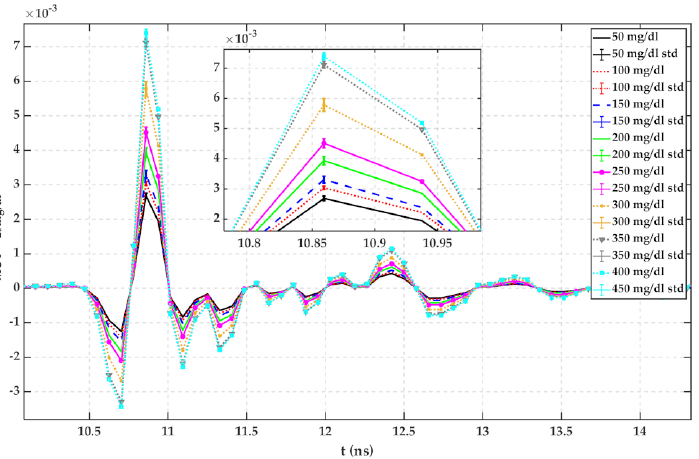
Figure 14. TD reflected signals regarding different MUTs (measured with m-sequence